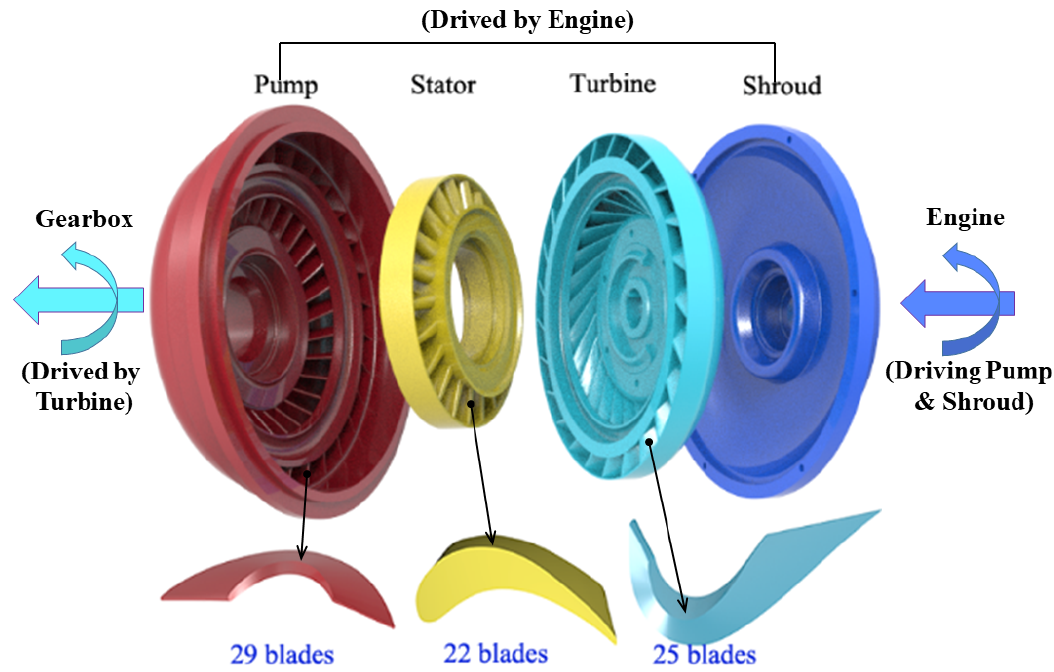
Figure 1. Illustration of a torque converter.